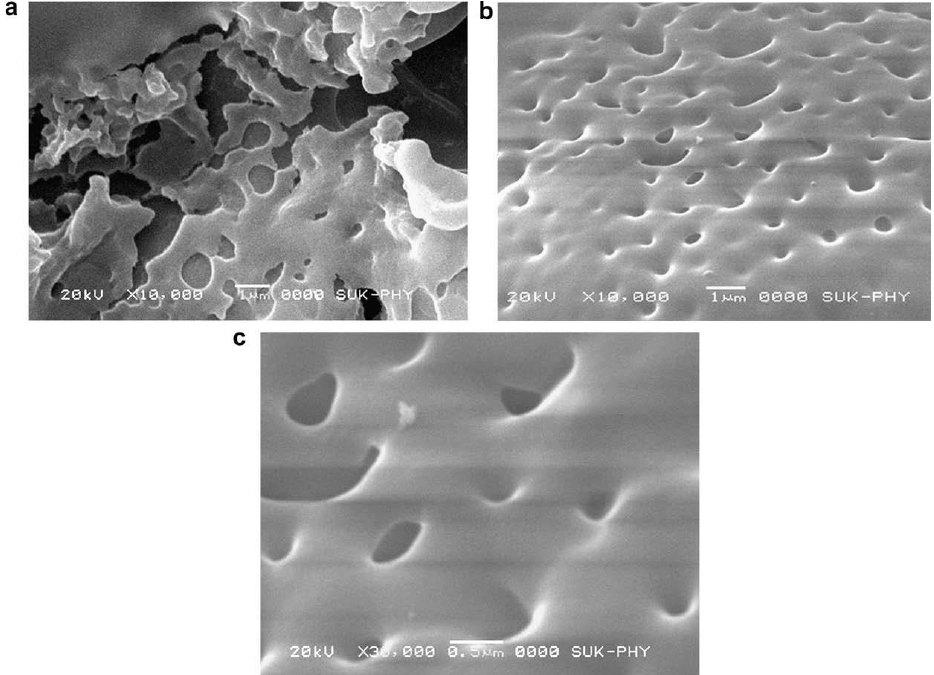
Figure 9. FESEM micrographs of ( a ) unmodified silica film and modified silica film at magnification of ( b ) 10,000× and ( c ) 30,000×. Reproduced with permission from [47]